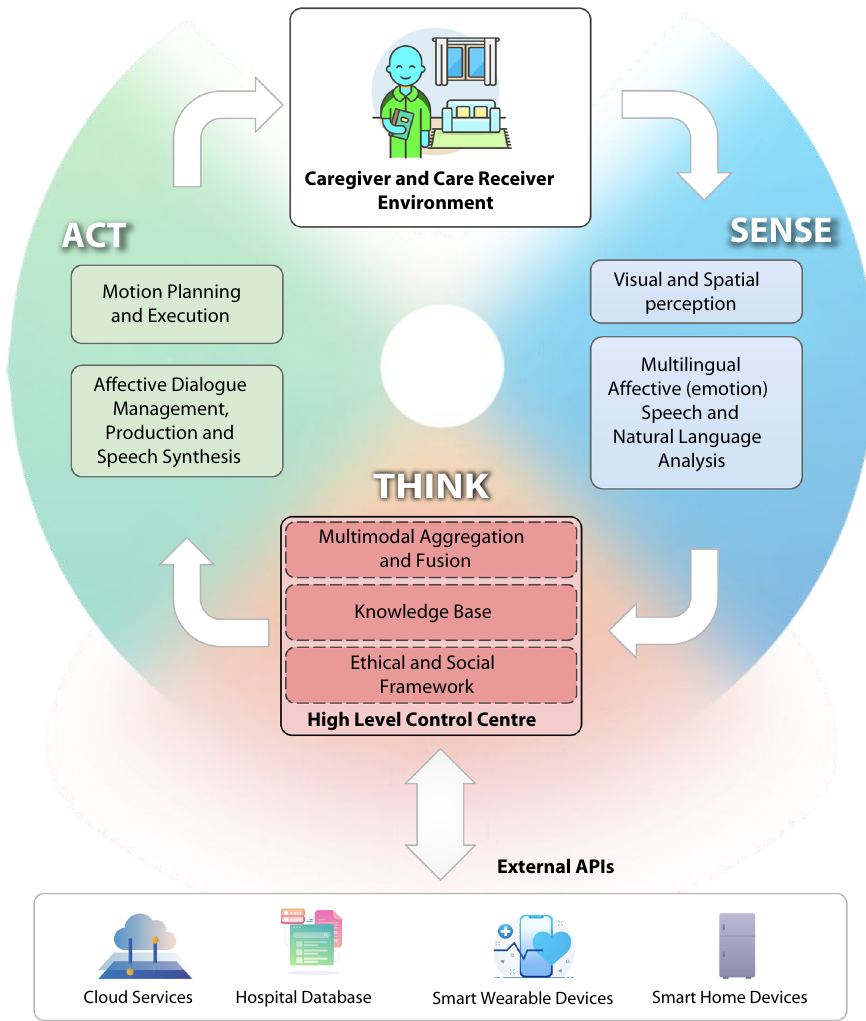
Figure 2: High - level overview of the planned CASIE